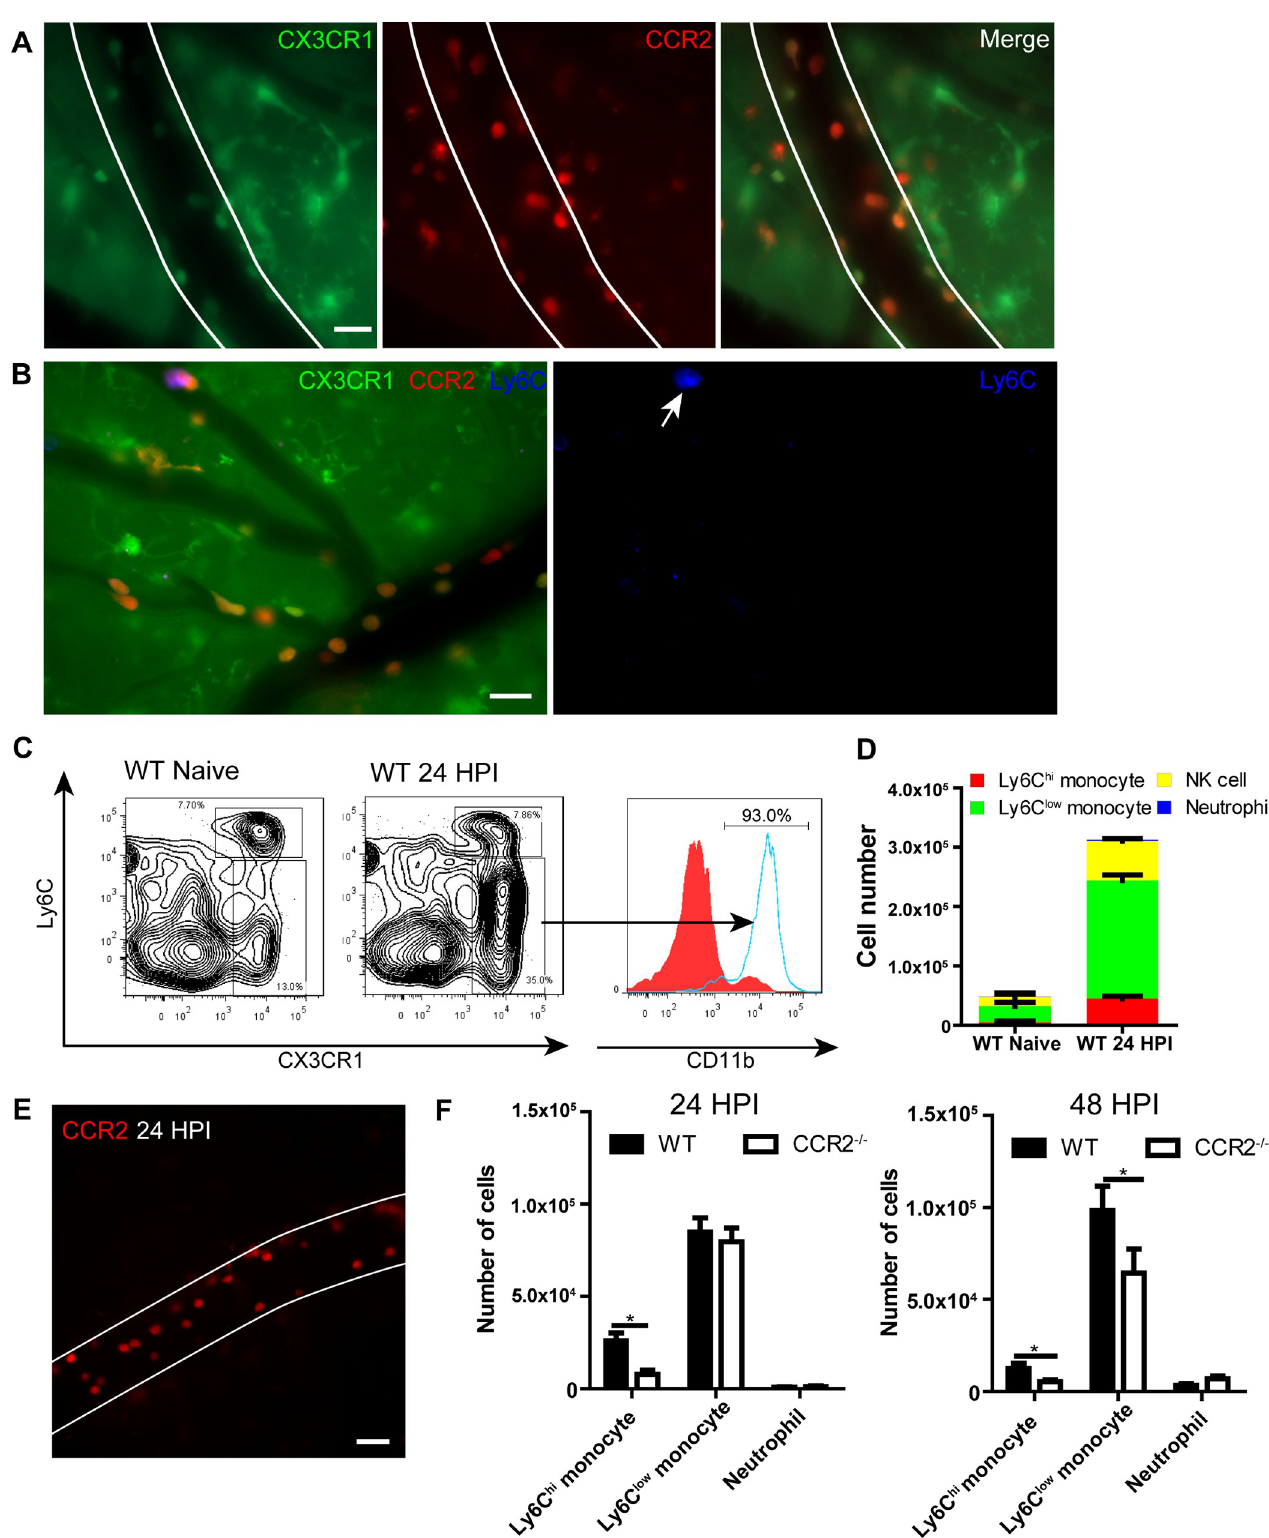
Fig 2. Recruited monocytes are mainly Ly6C low populations. (A) IVM images showing the expression of CX3CR1 and CCR2 on recruited monocytes in brain postcapillary venules of CX3CR1 gfp/+ CCR2 rfp/+ mice 24 h after infection with 20x10 6 C . neoformans (Green: CX3CR1, Red: CCR2). (B) Expression of